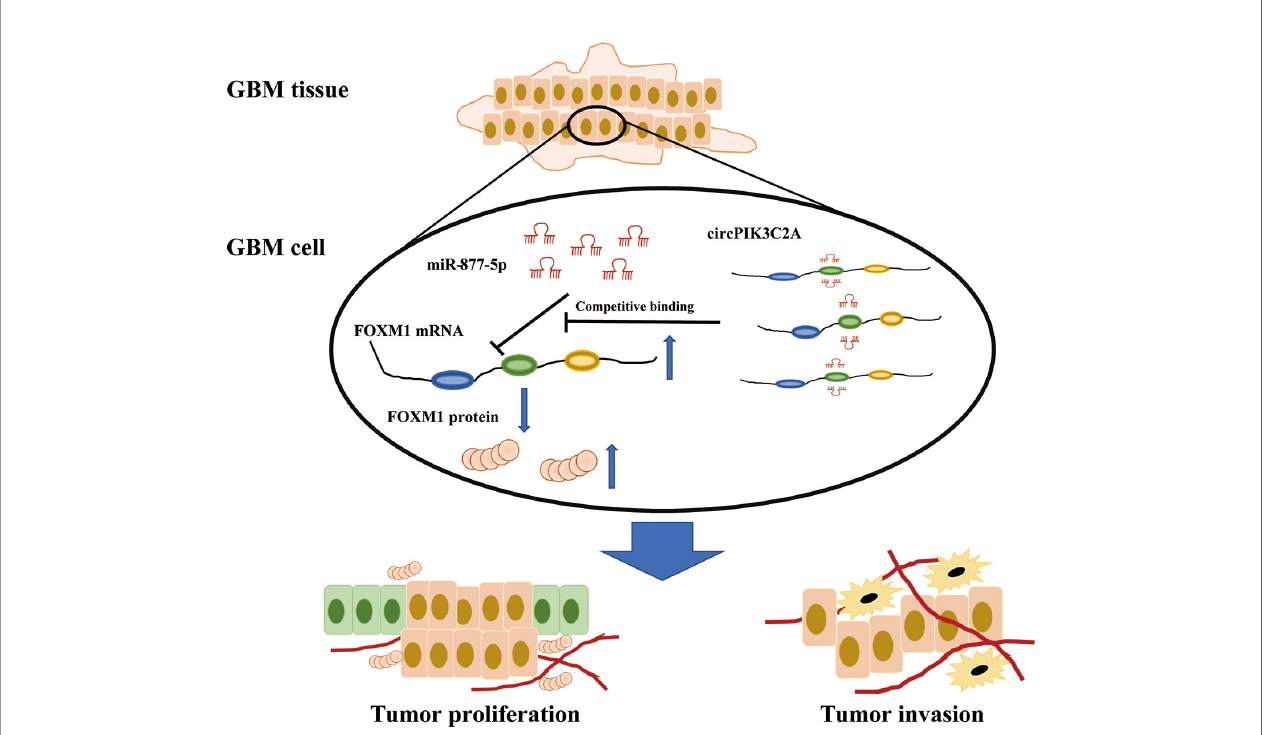
FIGURE 7 | Schematic summary. In the current study, we provide novel insights into the mechanisms underlying circPIK3C2A promoting GBM progression and invasion. Mechanistically, circPIK3C2A sponges miR-877-5p, acts as a ceRNA to regulate FOXM1 expression and modulates tumor cell function in vitro and in vivo .